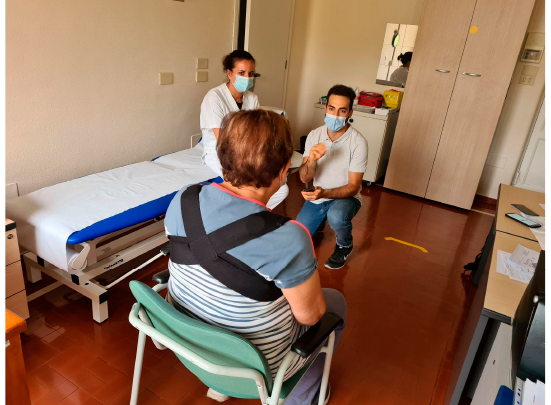
Figure 9. Picture of a patient during the ambulatory trial testing the smart harness’s